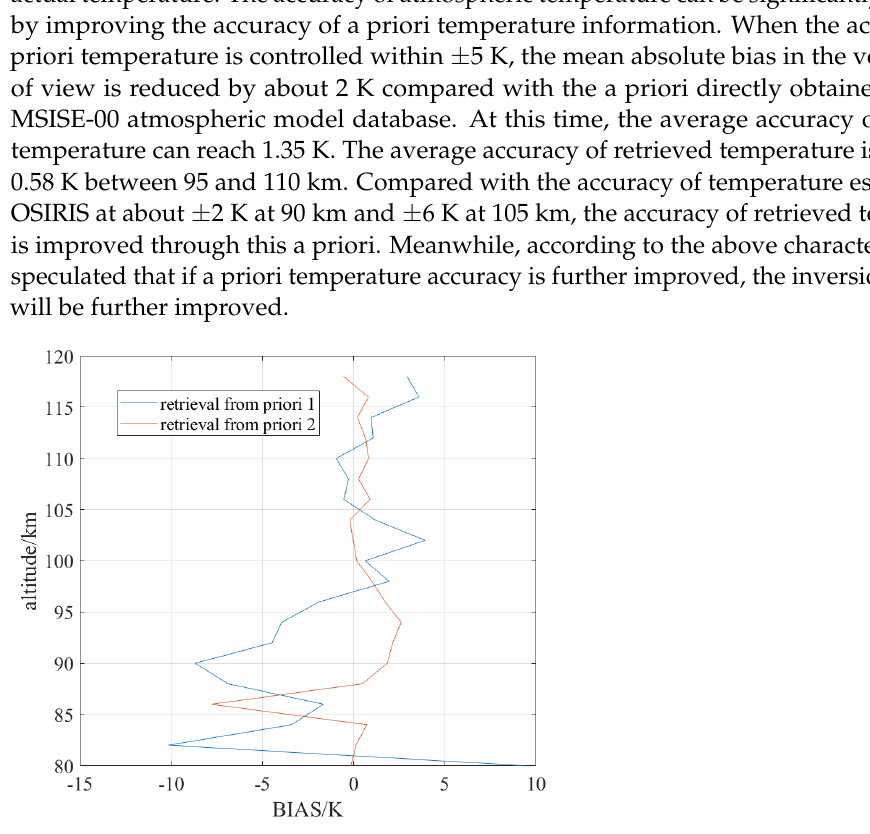
Figure 20. The bias between retrieved temperature and actual temperature based on different a priori constraints.